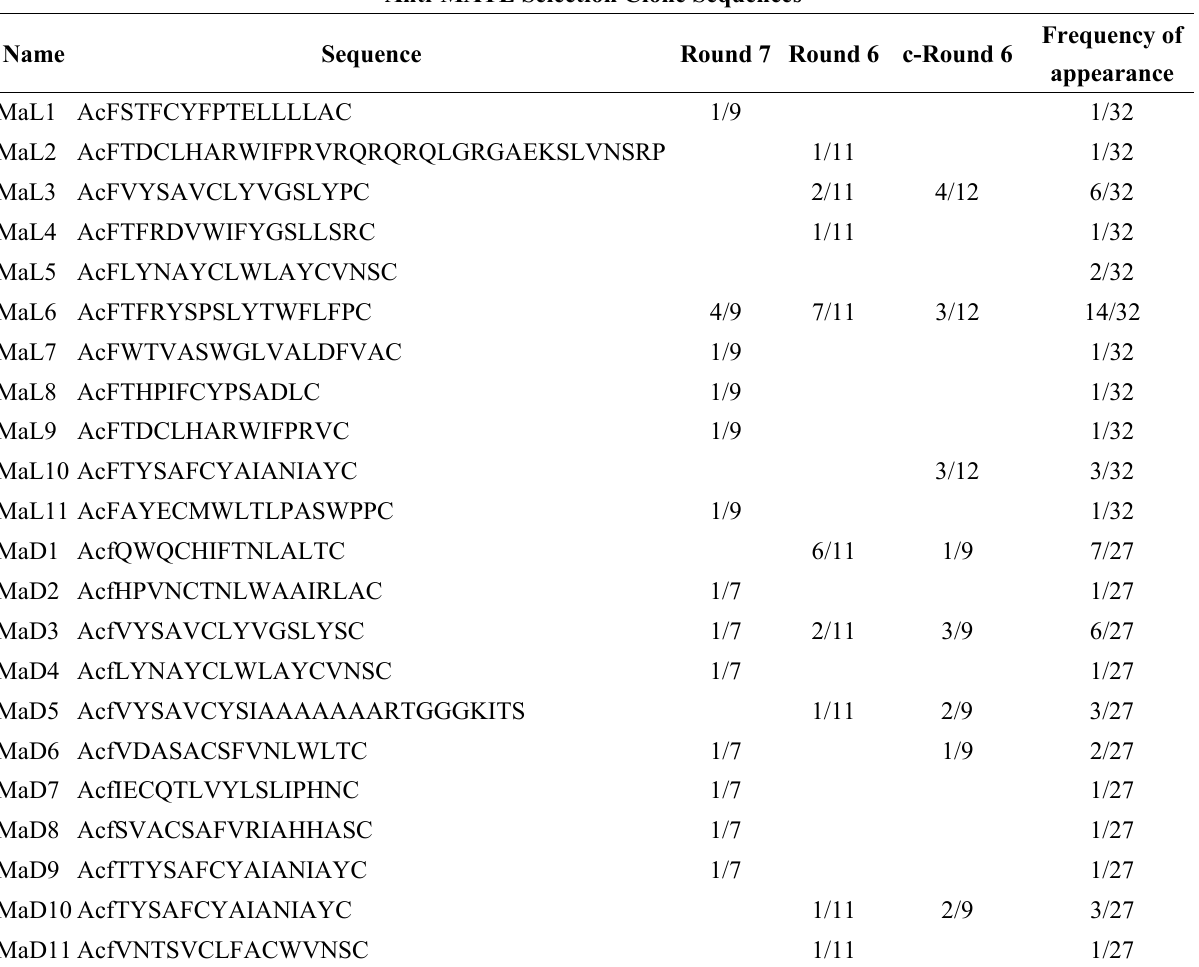
Table 1. Compiled peptide sequences from the 7th round of sub-selection 1, Round 6 of sub-selection 2, and c-Round 6 of sub-selection 2. Clones with the MaL-prefix originated from the L F-Library and clones with the MaD-prefix originated from the D F-Library. Clone residues are shown from the non-standard initiator amino acid represented by AcF for N -chloroacetyl- L -phenylalanine and Acf for N -chloroacetyl- D -phenylalanine to the engineered Cys. MaL2 and MaD5 were the result of frameshift mutations and have lost their engineered Cys, (Gly-Ser) linker, and stop 3